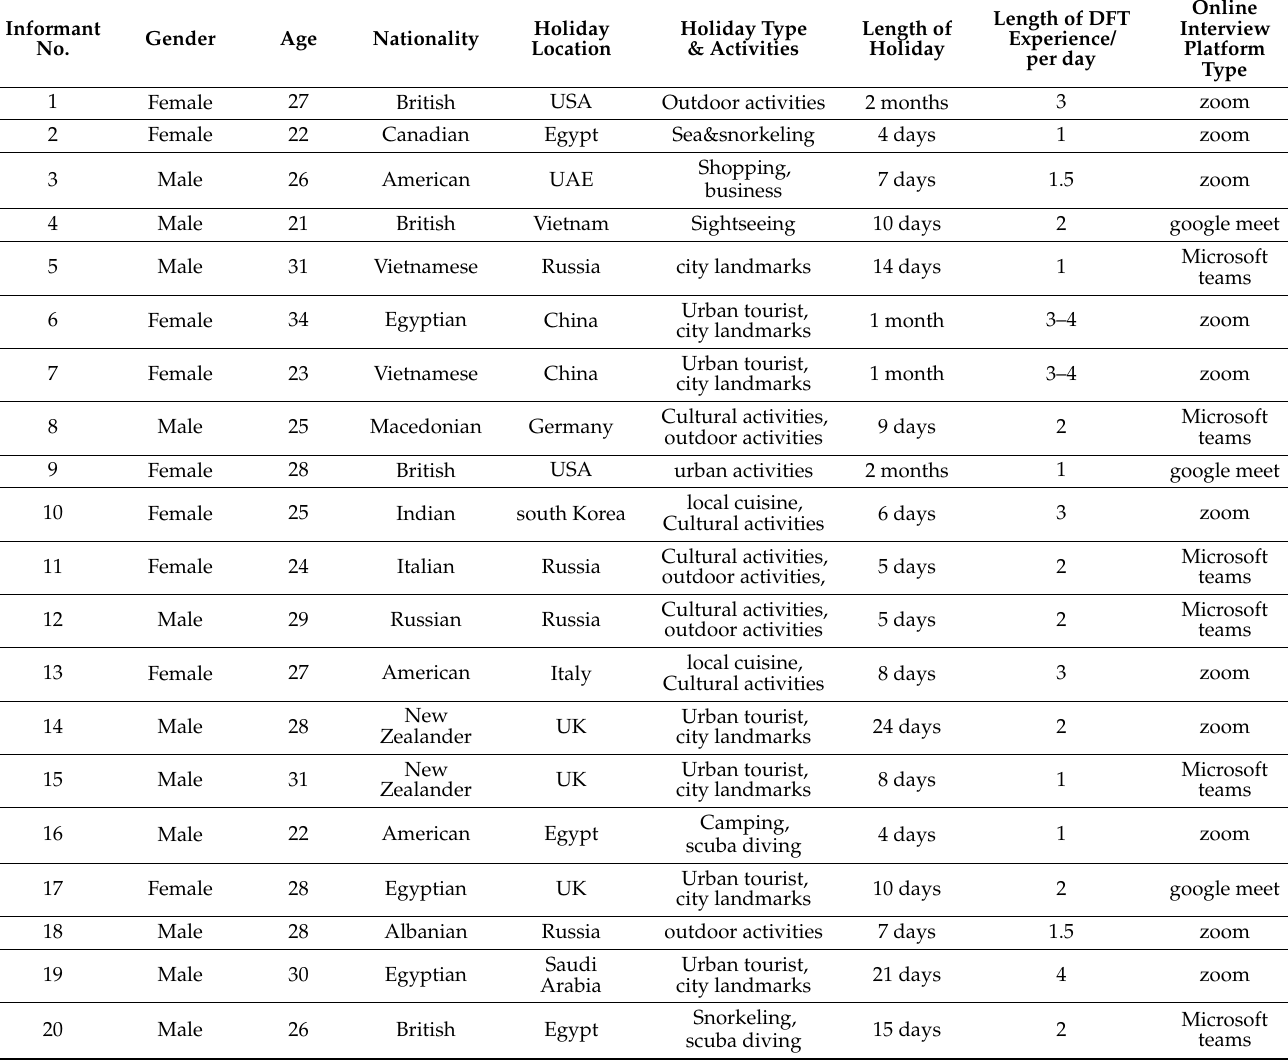
Table 1. Participants’ profile and DFT holiday